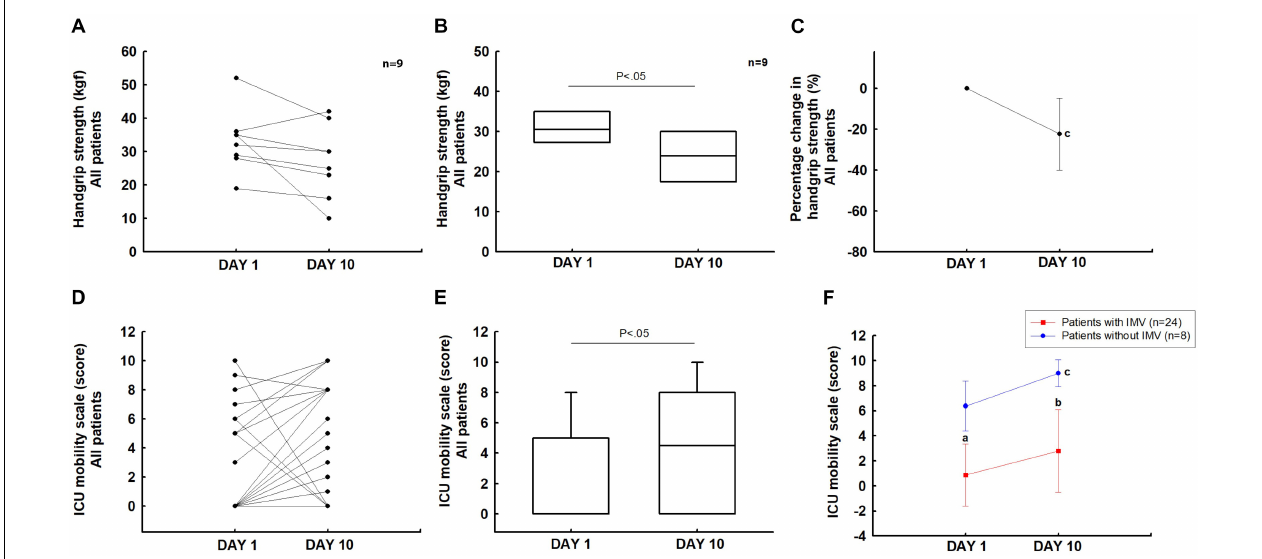
FIGURE 4 | Muscle strength and mobility: handgrip strength (A–C) and IMS scale (D–F) . a P < 0.05 vs patients without IMV on day 1; b P < 0.05 vs patients without IMV on day 10; c P < 0.05 vs day